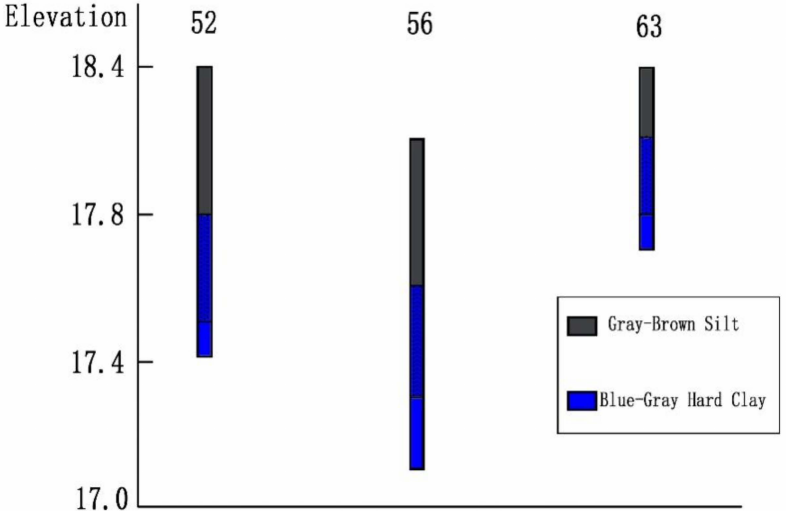
Figure 8. The sediment situation of No. 52, 56 and 63 drilling holes. In which, the black spots in the layer 2 (blue-gray hard clay) indicate the depth range where pottery sherds were